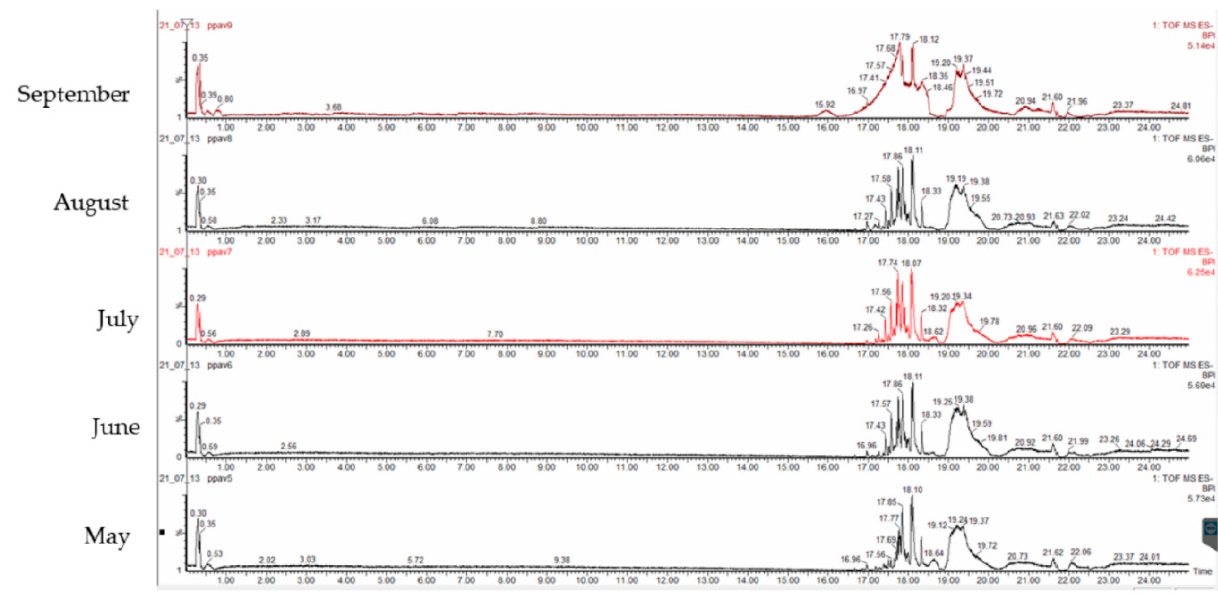
Figure 3. Chromatograms of the UPLC-PDA-ESI-QTOF analyses of P. pavonica .